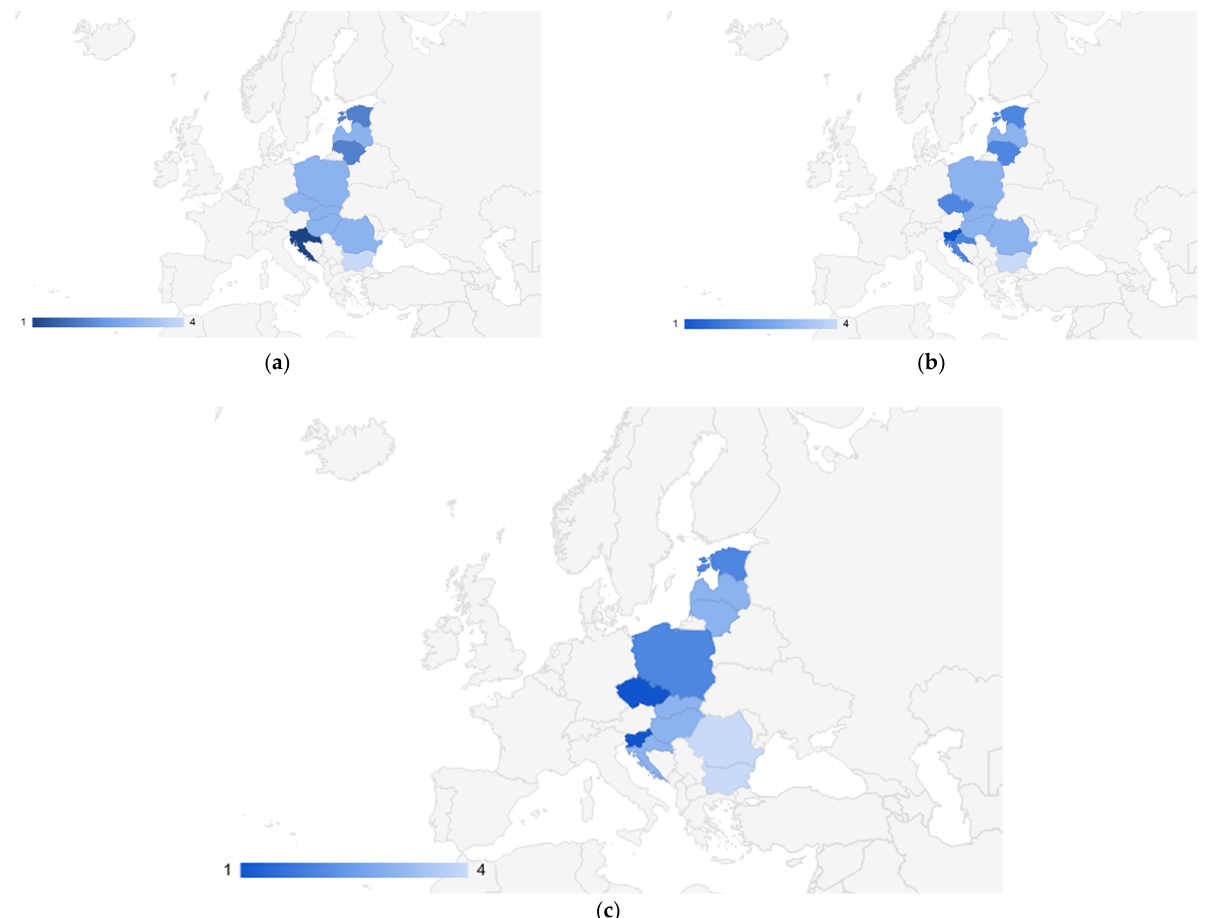
Figure 7. Level of CEE countries in terms of digitalization of their enterprises: small ( a ), medium ( b ) and large ( c ).